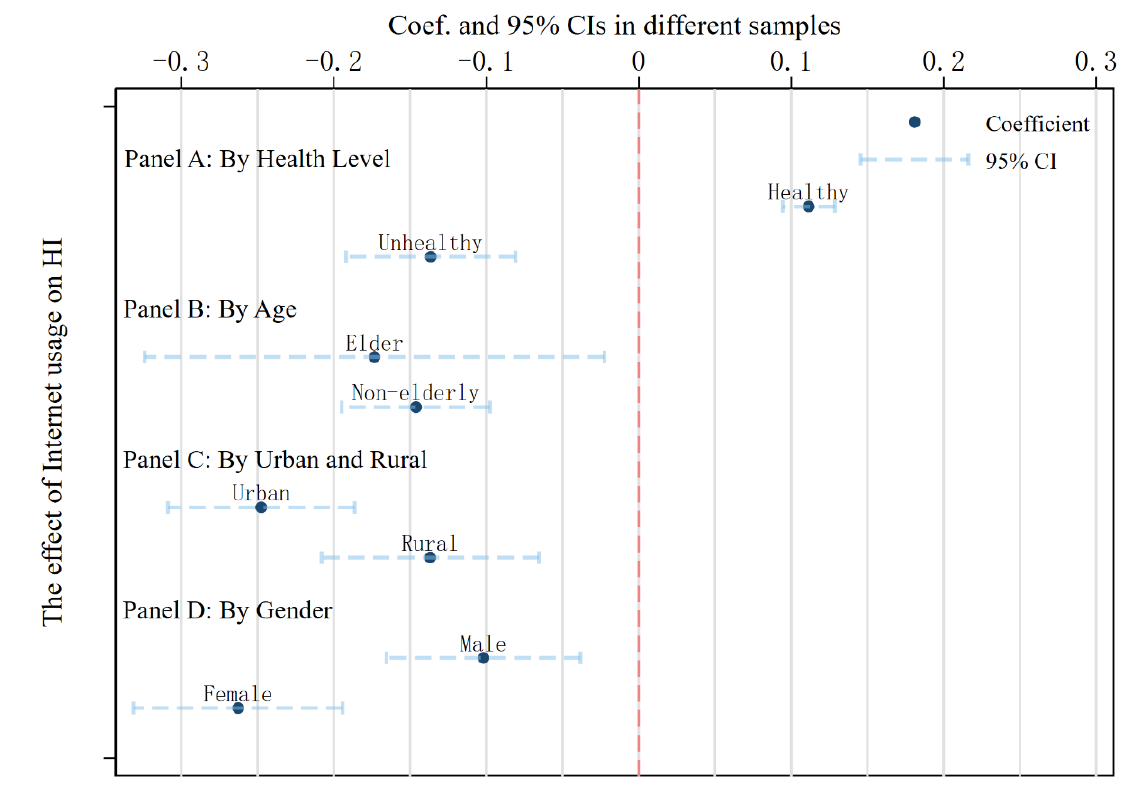
Figure 1. Heterogeneity test results.